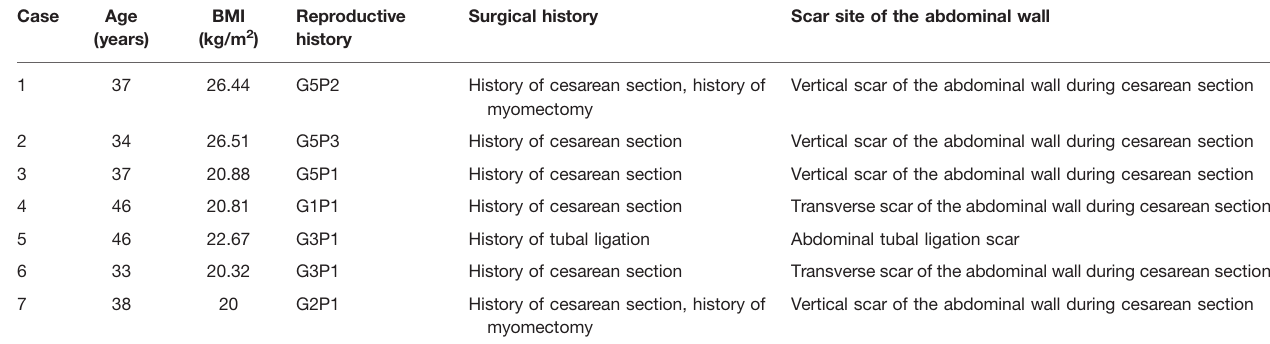
TABLE 2 | General information of